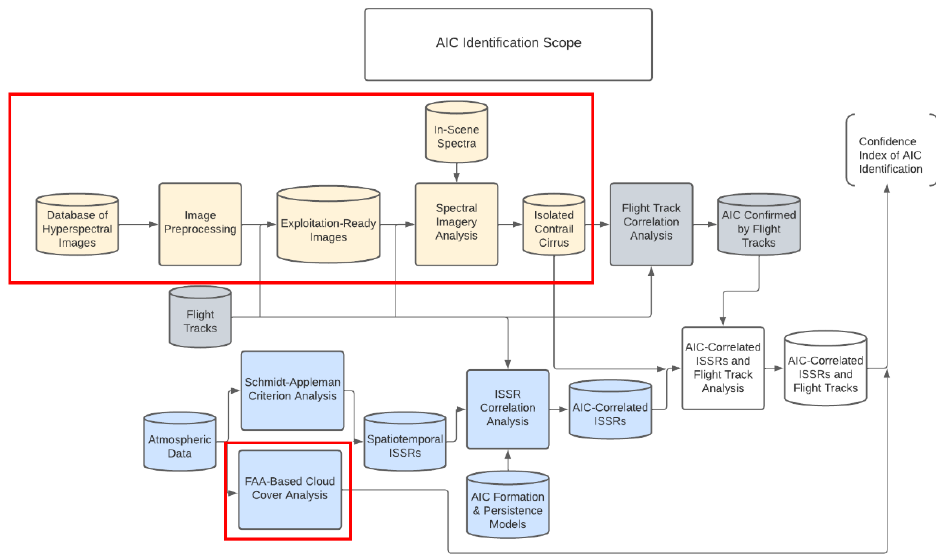
Figure 1. AIC Identification Scope Block Diagram.